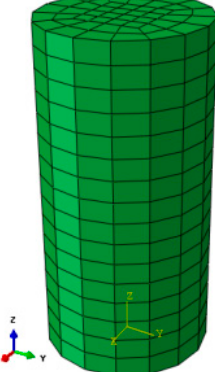
Figure 2. Triaxial test finite element calculation model.